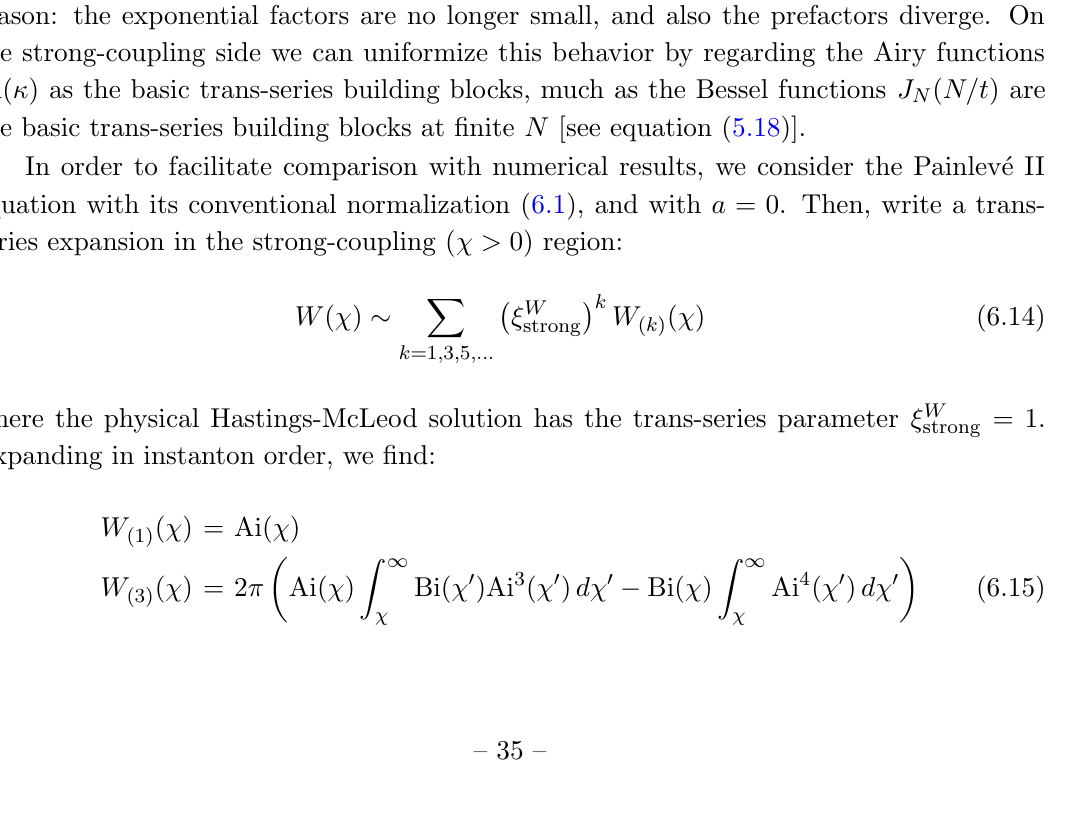
( N; N ) = J N ( N ) [blue (1) ( N; N ) [red circles] in (5.13). (3)